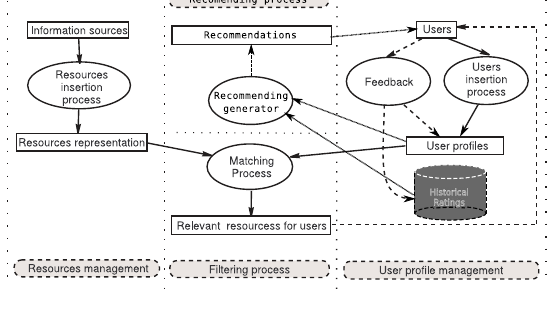
Fig. 2. Components of a